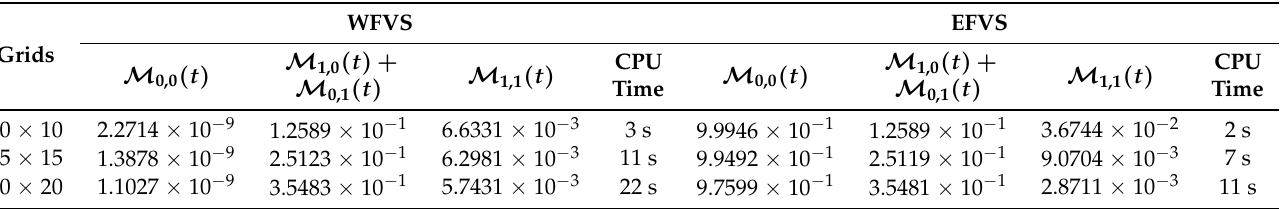
Table 2. Relative error for the weighted moments at different grid points for the test case with S = 1 and breakage functions b 1 at t = 10.